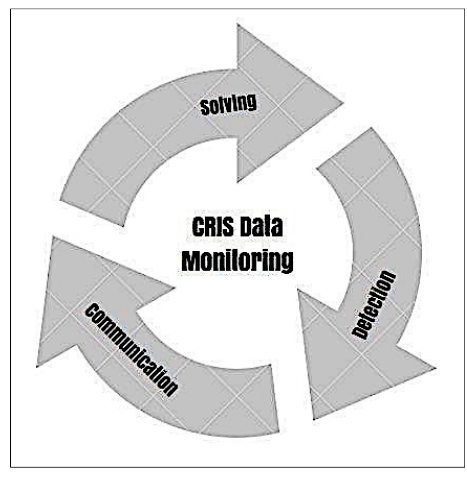
Figure 11. CRIS data monitoring cycle.